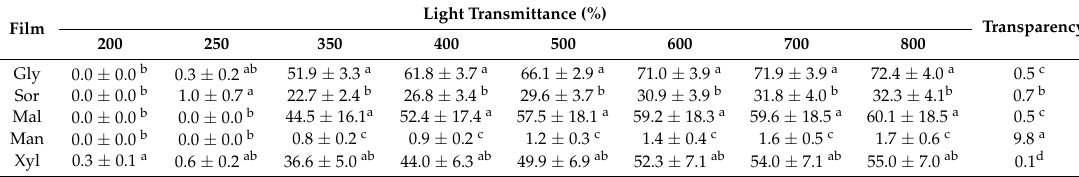
Table 1. Light transmittance and the transparency of protein films from jumbo squid ( Dosidicus gigas ) with different